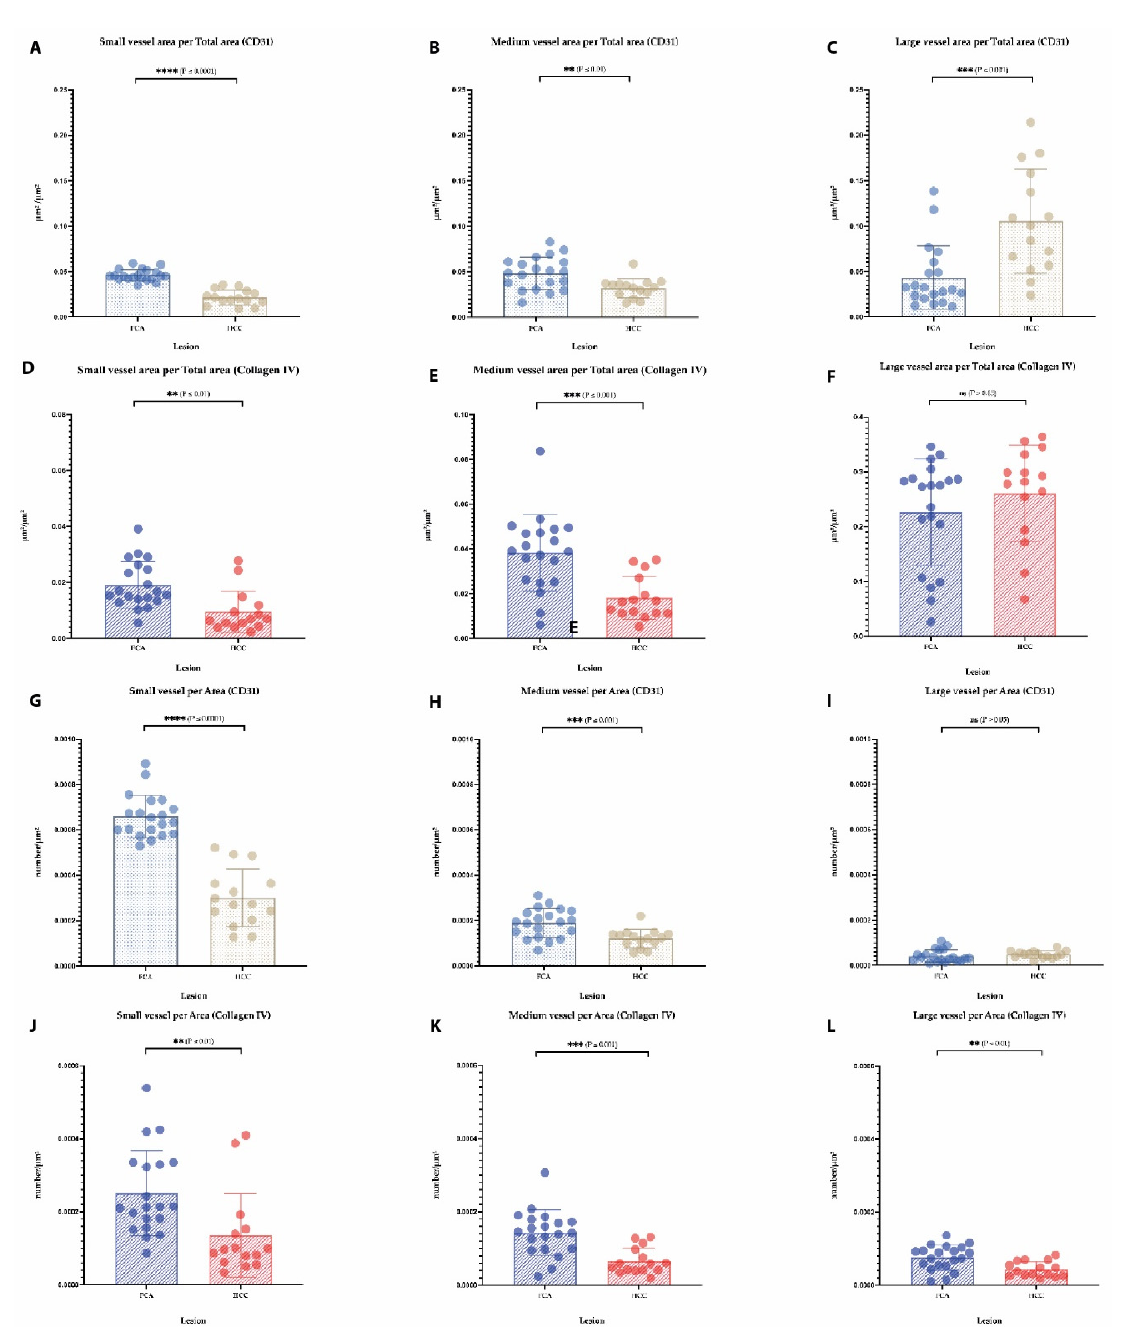
Figure 4. Analysis of vessel area and vessel number per lesion. Evaluation of subgrouped vessels per total area in CD31 ( A – C ) and Collagen IV staining ( D , E , F ). Subgrouped vessels per area in CD31 ( G – I ) and Collagen IV staining ( J , K , L ). Error bars show the mean and standard deviation for each lesion. p -values: not statistically significant (ns) p value > 0.05; for statistical significance, accepted p value ≤ 0.05., ** p value ≤ 0.01, *** p value ≤ 0.001, and **** p value ≤ 0.0001.